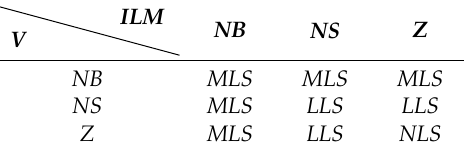
Table 2. IF-THEN fuzzy